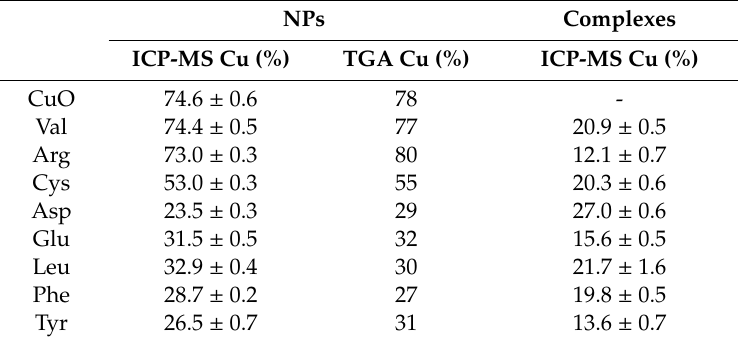
Table 2. Total copper content in pristine and treated CuO NPs measured by Inductively Coupled Plasma Mass Spectrometry (ICP-MS) and calculated on the basis of TG analysis, and total copper content in Cu-amino acid complexes measured by